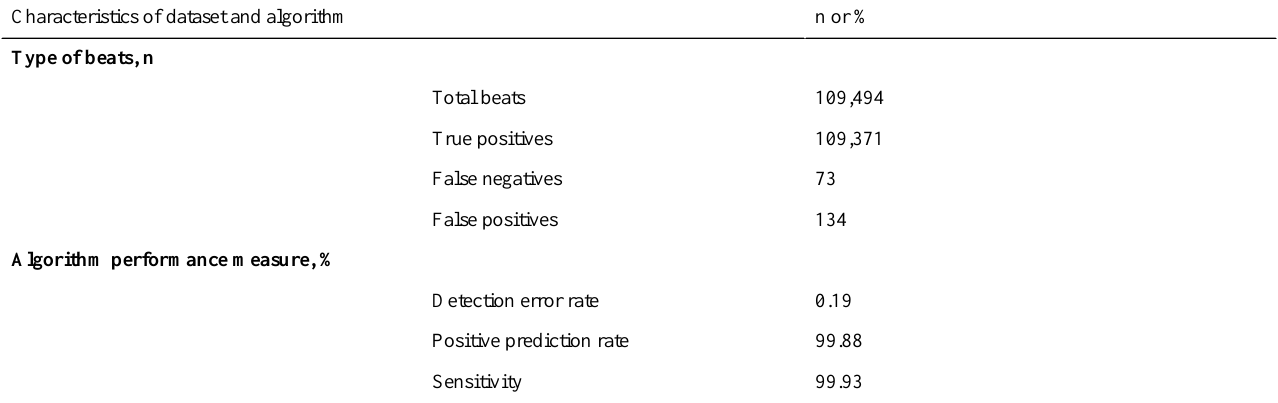
Table 2. Performance of R-wave peak detection algorithm.